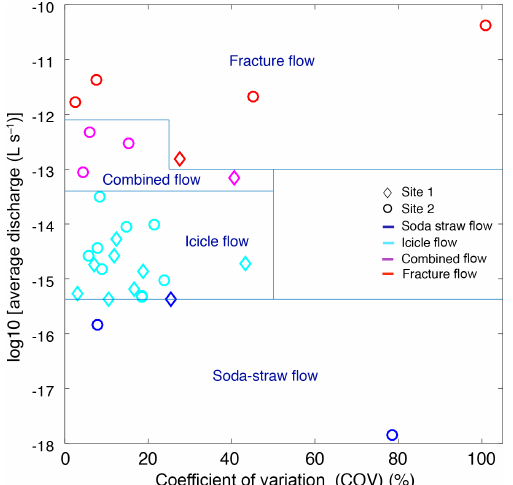
Table 1. MDS cluster groups with statistical properties of Cham- ber 1 drip data.